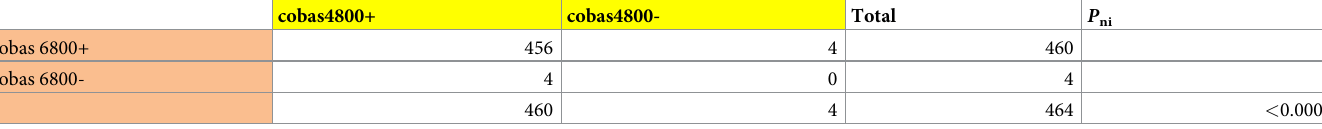
p ni = p-value from non-inferiority testing. A P-value < 0.05 signifies that the null hypothesis of inferiority is rejected and that the sensitivity of the new cobas 6800 testing is non-inferior to the original cobas 4800